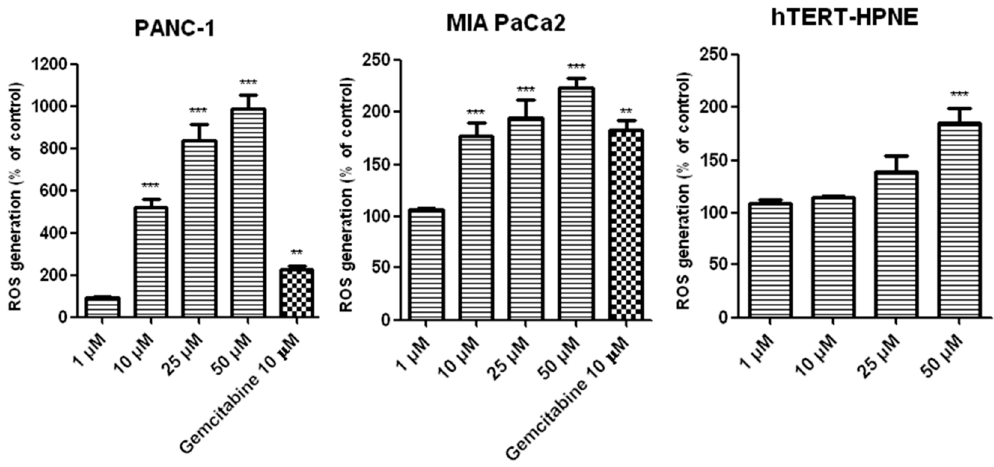
Figure 5. The levels of ROS induced by T1 vanadium complex in PANC ‐ 1, MIA PaCa2 and hTERT ‐